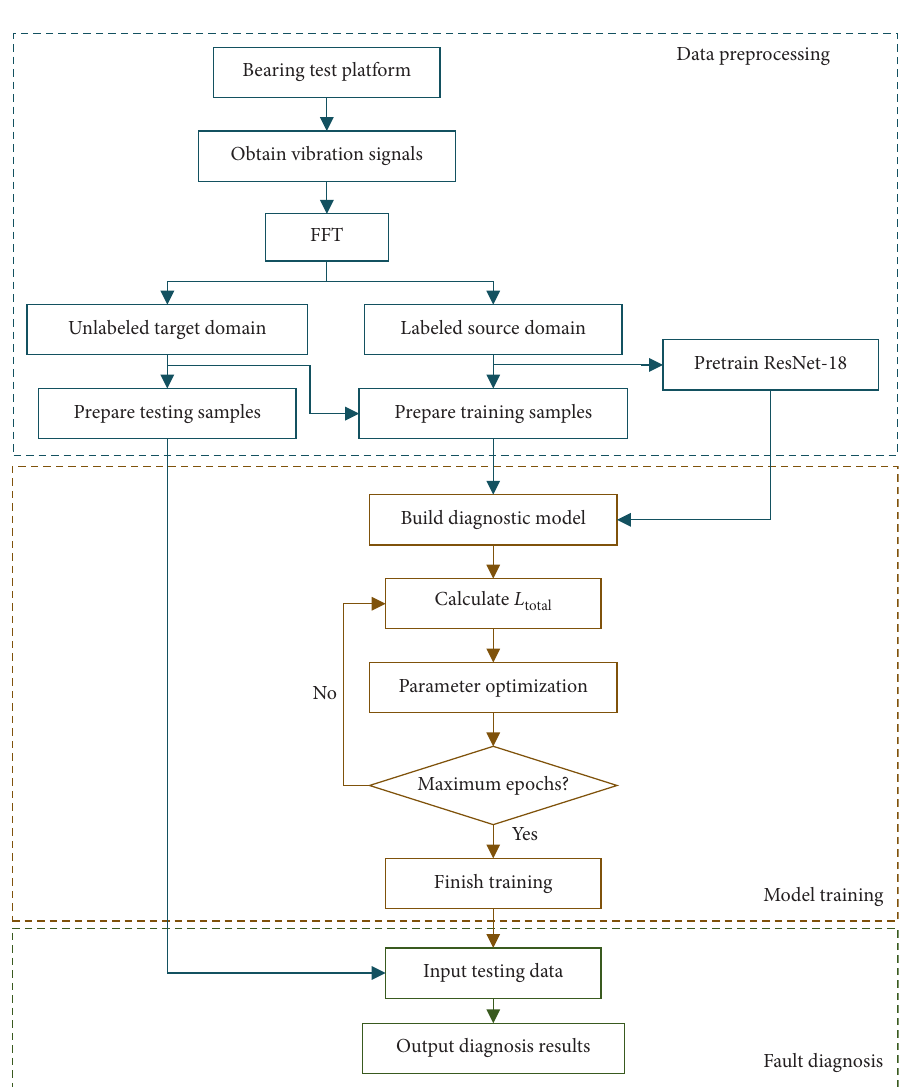
Figure 4: Flowchart of the proposed MLDA model.